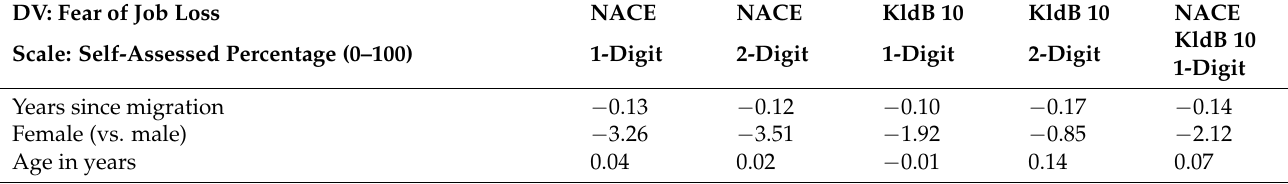
Table A3. Linear regression M2b with alternative FE specifications, first